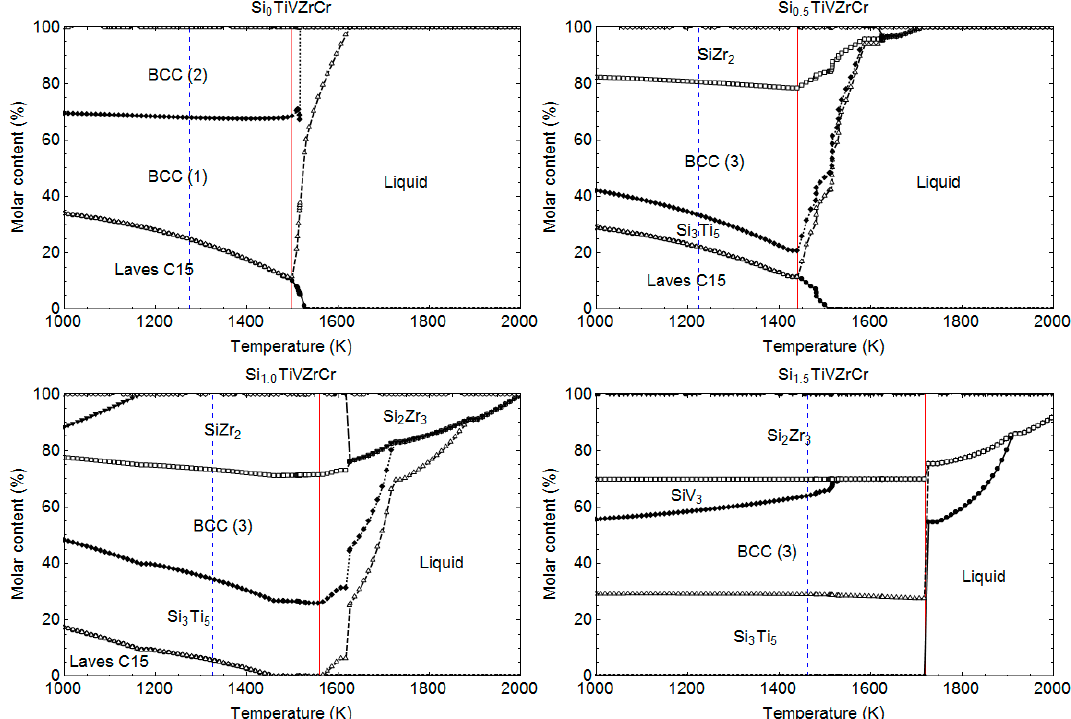
Figure 2. Property diagrams showing the proportions of phases present (mole fraction) for each of the alloys under consideration (TiVCrZr-Si x ( x = 0, 0.5, 1, 1.5)), calculated from Thermo-Calc. The solid red line denotes the melting temperature, T m , while the dashed blue line denotes T e ff = 0.85 T m , giving an example of which present phases may be found using Chvorinov’s rule. T e ff values are determined from Equation (2).